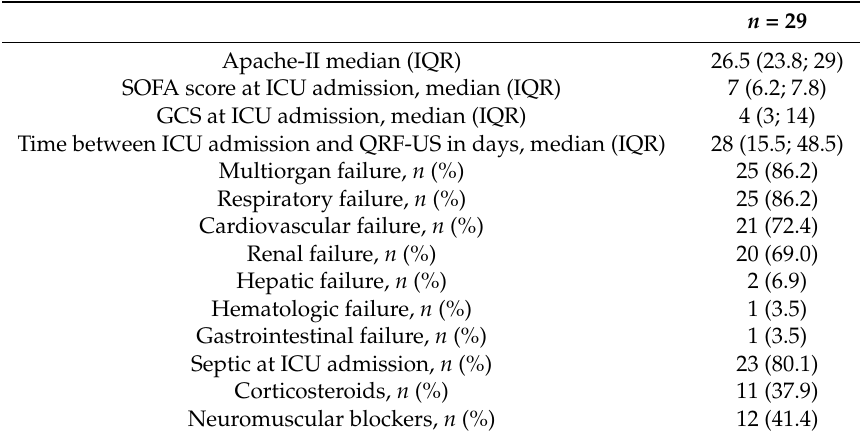
Table 2. Clinical characteristics of the cases.